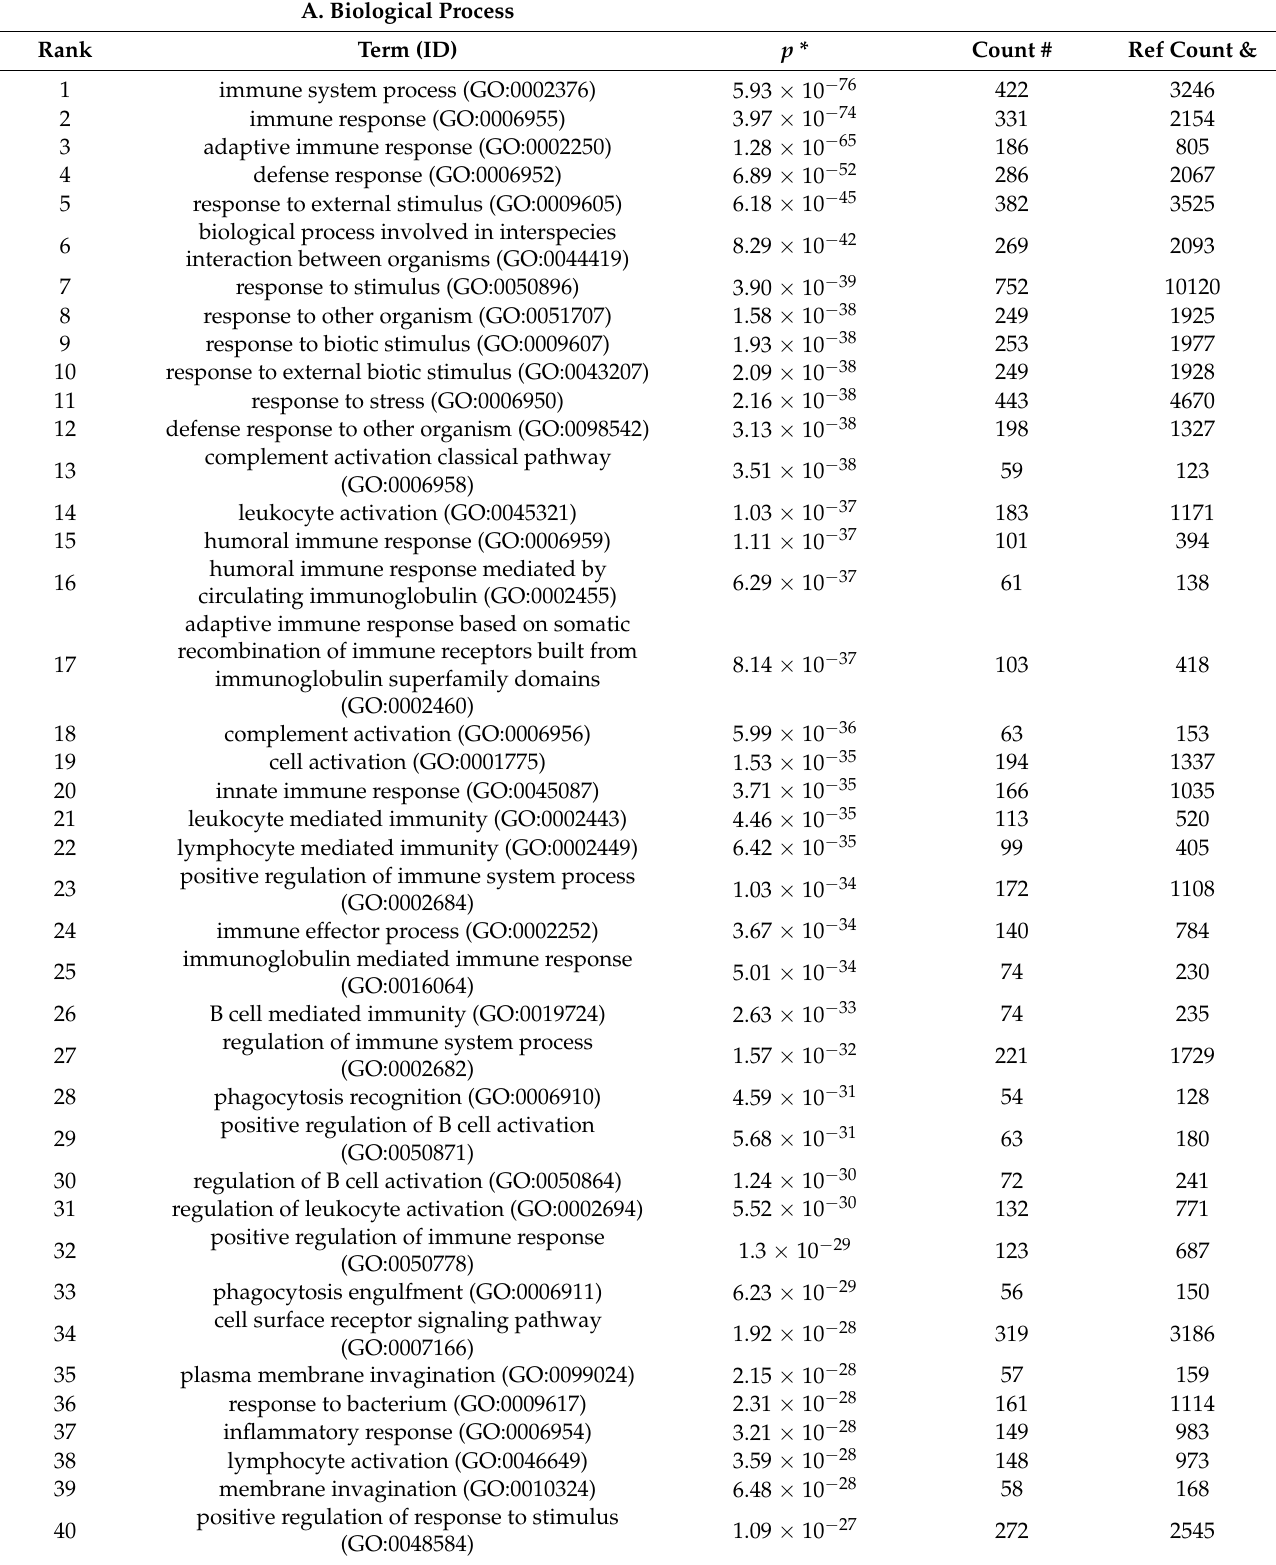
Table 4. Top 40 enriched gene ontology terms identified by